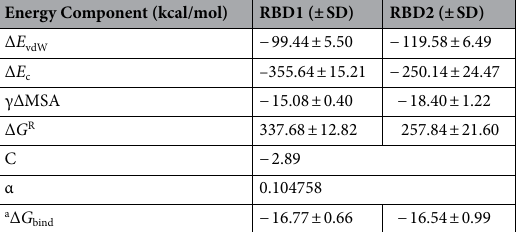
Energy Component (kcal/mol) RBD1 (±